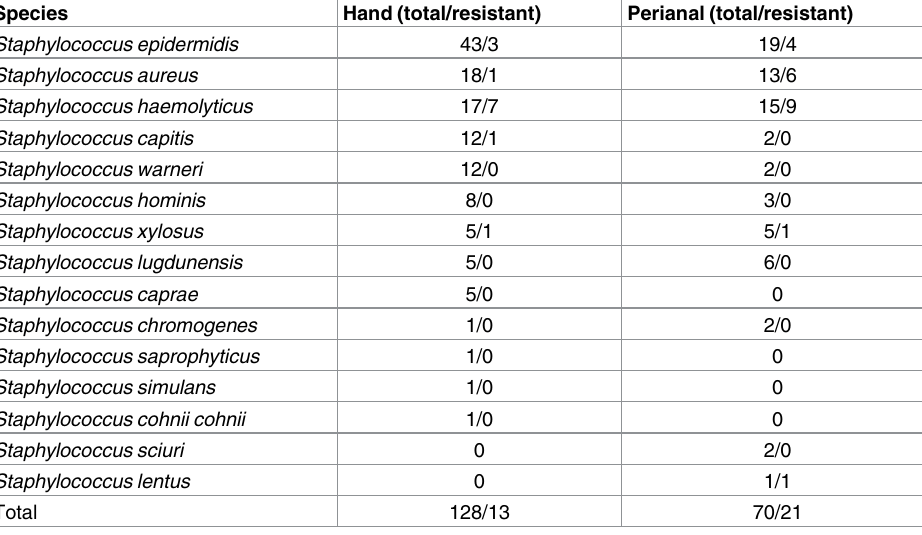
Table 2. Staphylococcal species isolated during the study.